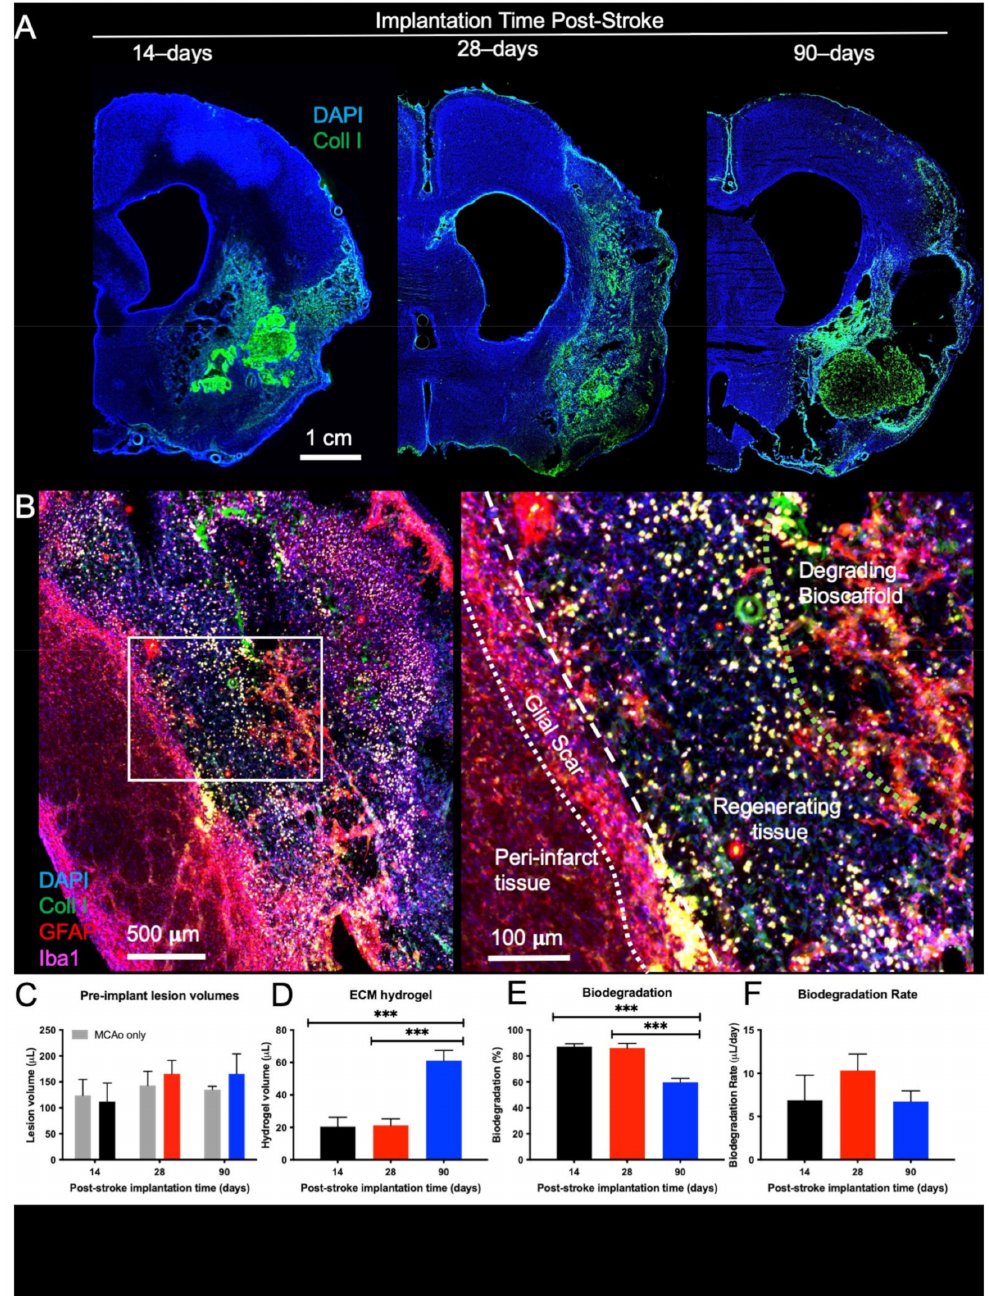
Figure 2. Macroscopic distribution and biodegradation of ECM hydrogel. ( A ) Macroscopic images were acquired to examine the distribution of the remaining ECM hydrogel 14-days after implantation. The 90-days post-stroke implantation condition shows limited biodegradation, while the 14- and 28-days injections revealed efficient biodegradation with only small volumes of hydrogel remaining. ( B ) A higher magnification image of the 28-days implantation illustrates the process of biodegradation. The boundary between host and lesion cavity is defined by the glial scar (GFAP); therefore, the cells (DAPI) present within this lesion are considered regenerating tissue. The remaining bioscaffold (Collagen I) can be seen surrounded by astrocytes (GFAP) and macrophages (Iba-1). ( C ) Lesion volumes were calculated from T 2 -weighted MR images acquired 10-days post-stroke. Random group assignment of rats resulted in equivalent lesion volumes in all conditions. ( D ) The amount of remaining ECM hydrogel was quantified to determine the biodegradation for the 14-, 28-, and 90-days post-stroke implantations. ( E ) The 14- and 28-days post-stroke implants had no significant difference in the percentage of biodegradation, while the 90-days post-stroke implantation condition demonstrated significantly less biodegradation (*** p < 0.001). ( F ) However, the degradation rate ( µ L/day) was not significantly different between time